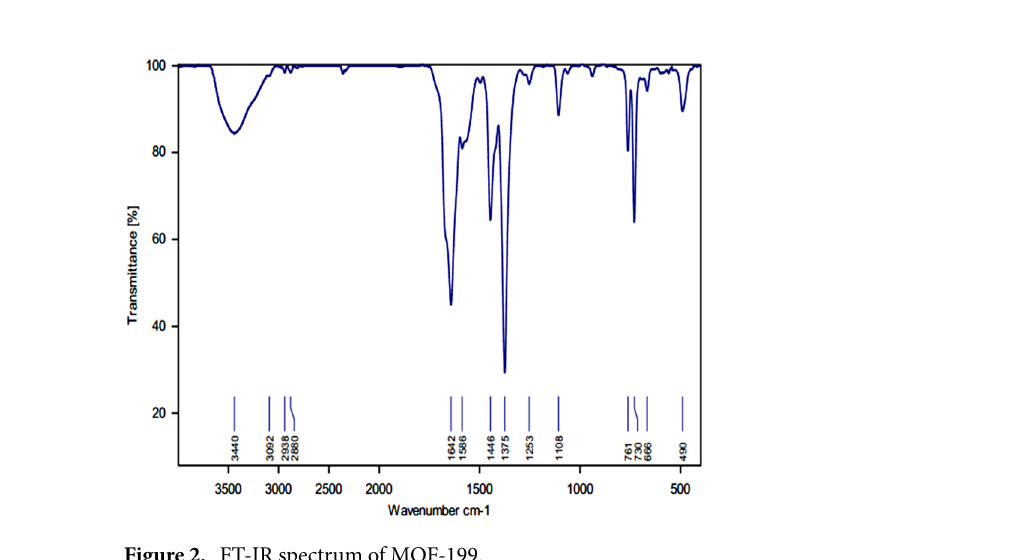
Figure 2. FT-IR spectrum of MOF-199.